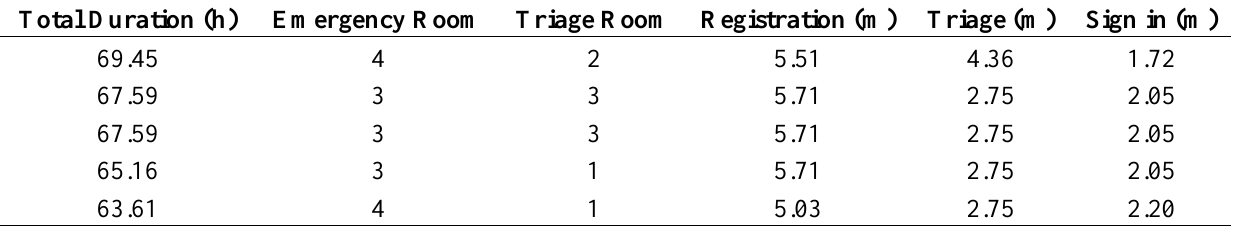
Table 12. KPI along generations during the minimization